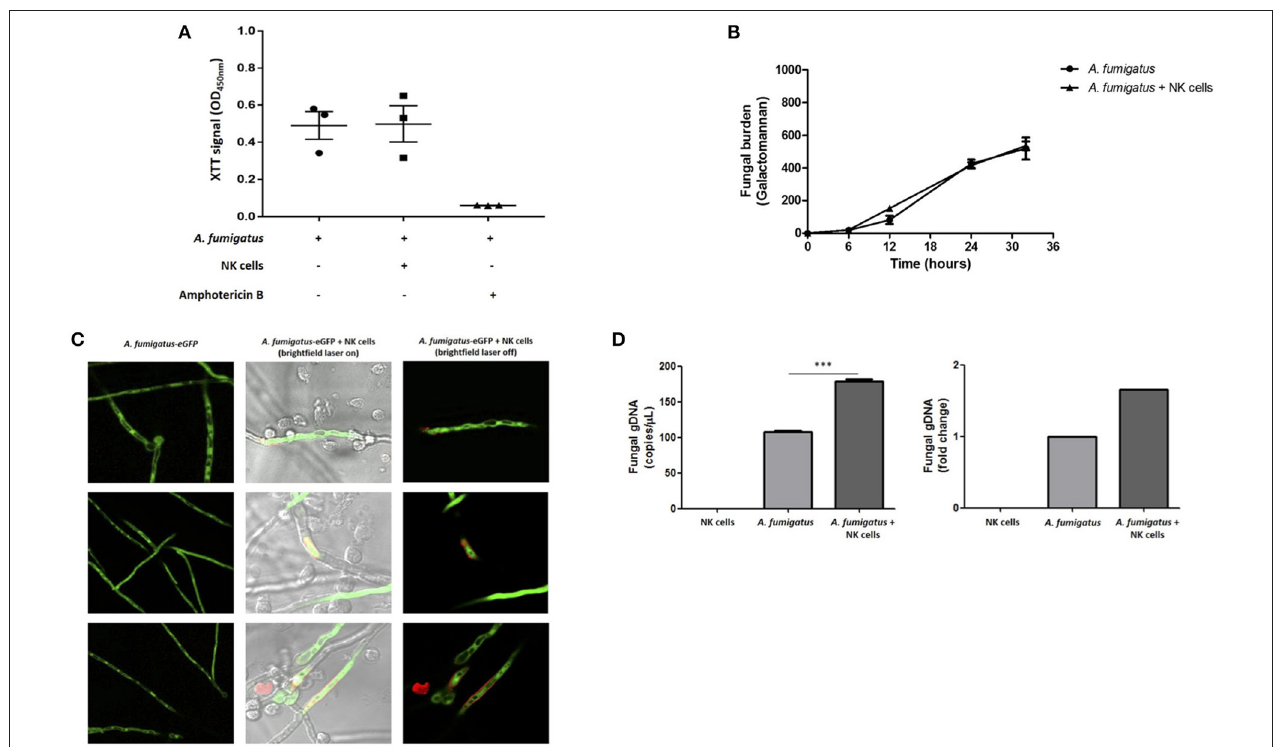
FIGURE 6 | NK cell interaction with A. fumigatus hyphae results in fungal DNA release (A) . Analysis of fungal burden by XTT assay. A. fumigatus germlings were incubated overnight either in the absence or presence of NK cells at a MOI of 0.05. Graph shows the mean ± SEM of fungal burden. Statistical analysis was performed using the Student’s paired t -test. n = 3 (B) . Analysis of fungal burden by galactomannan assay. A. fumigatus germlings were incubated overnight either in the absence or presence of NK cells at a MOI of 0.05. The culture supernatant was collected at different time points and galactomannan was determined. Graph shows the mean ± SEM of fungal burden. This data is representative of three independent experiments. Statistical analysis was performed using the Student’s unpaired t -test. Y –axis is Galactomannan (C) . NK cell contact with A. fumigatus hyphae leads to DNA release. A. fumigatus germlings were incubated overnight in presence or absence of NK cells at MOI = 0.05. After the incubation period, propidium iodide was added to all wells and fungal viability was analysed by confocal microscopy. A. fumigatus are indicated in green and PI staining indicated in red. (D) NK cell interaction with A. fumigatus results in fungal DNA release. A. fumigatus germlings were incubated overnight in presence or absence of NK cells at MOI = 0.05. After the incubation period, culture supernatants were collected and fungal gDNA was quantified by qPCR. Results are shown in copies/ µ L and fold change. *** p < 0.001.